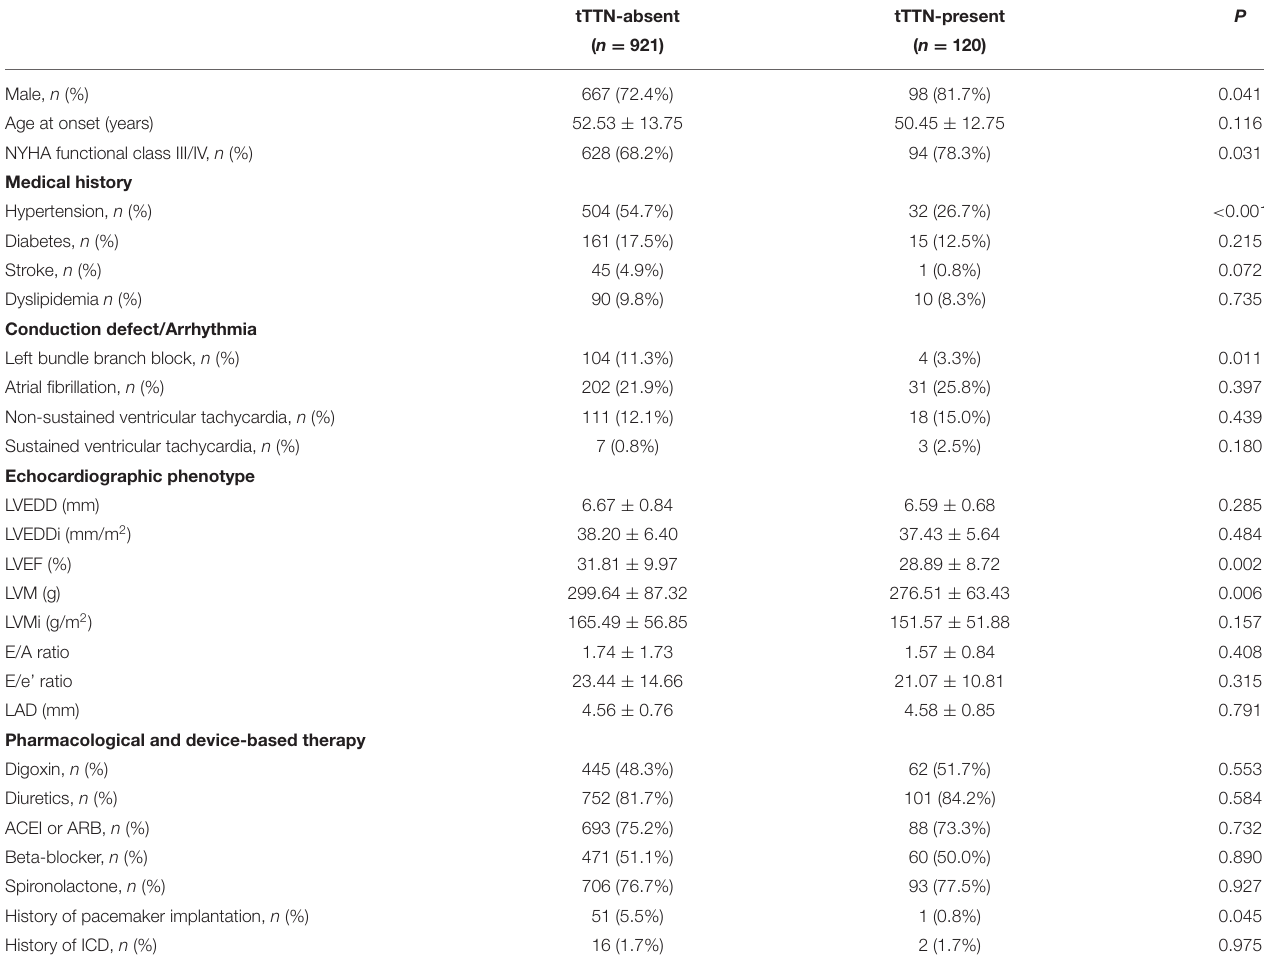
TABLE 2 | Clinical feature of DCM stratified by tTTN status.